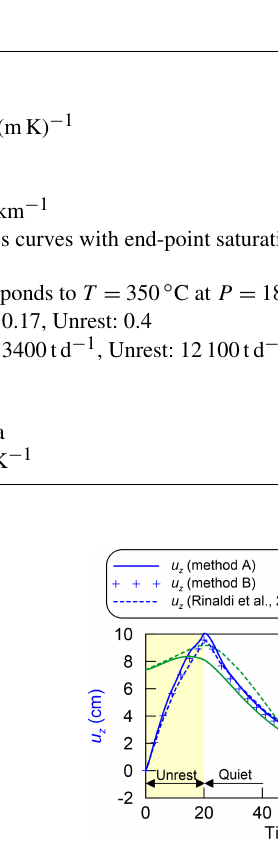
Figure 7. Vertical components of the ground displacement ( u z ) and gravity change ( (cid:49)g z ) at the centre OP ( r = 0, z = 0) against